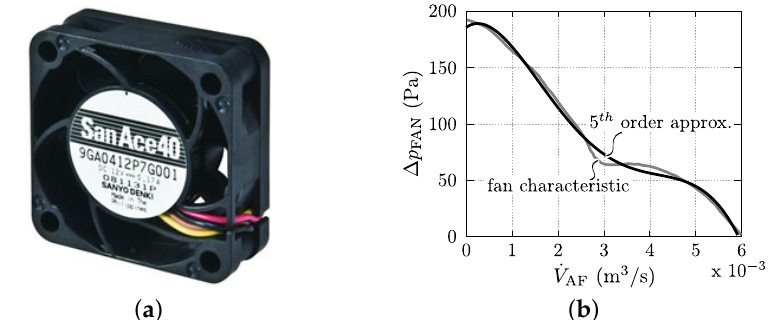
Figure 12. ( a ) Picture of the selected fan: SanAce40GA, type 9GA0412P7G001, 40 mm × 40 mm × 15 mm, 12 V; ( b ) Datasheet pressure-flow curve (gray line) and 5th order approximation (black